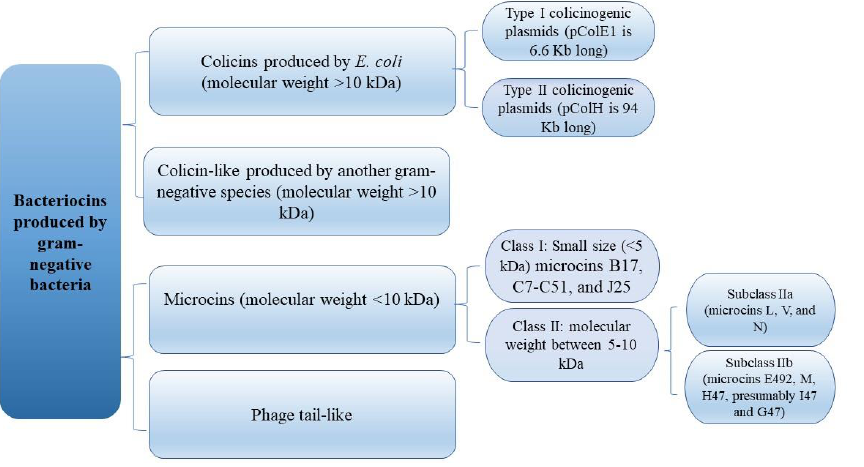
Figure 1. Classification of bacteriocins produced by Gram-negative bacteria.